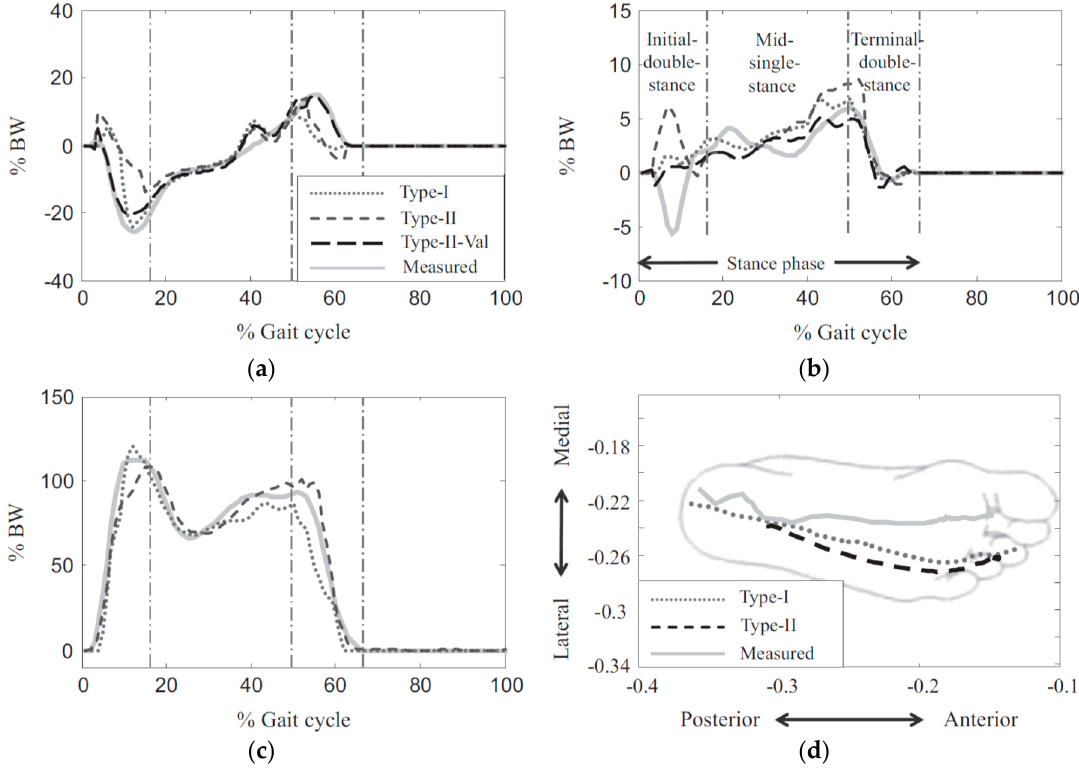
Figure 14. Comparison of the estimated and measured anterior-posterior ( a ), Medio-lateral ( b ) and vertical ( c ) GRFs and CoP trajectory ( d ) (after [71]).